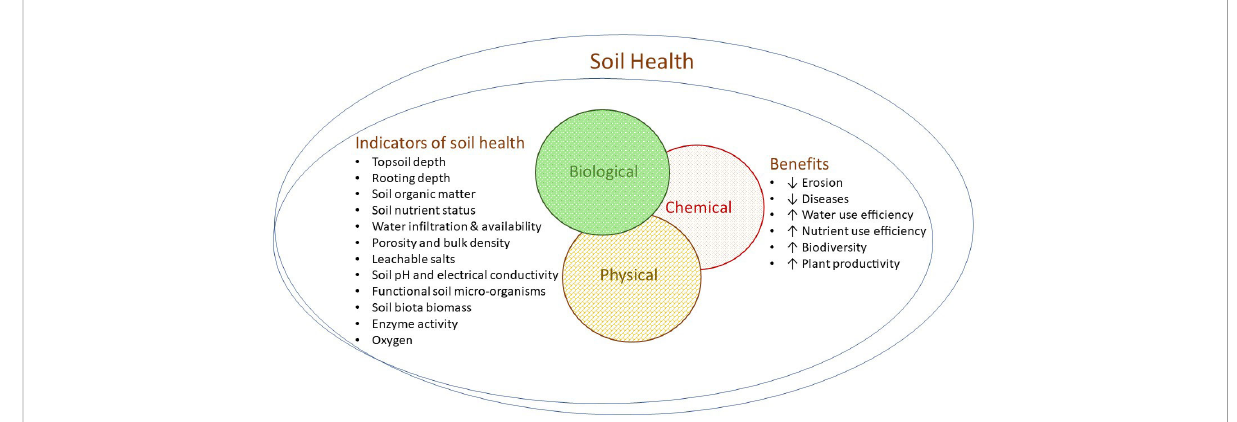
FIGURE 2 Indicators and bene fi ts of optimum soil health. Soil health is comprised of the interactive physical, chemical and biological spheres and can be assessed through various measurable indicators and resulting bene fi ts in the